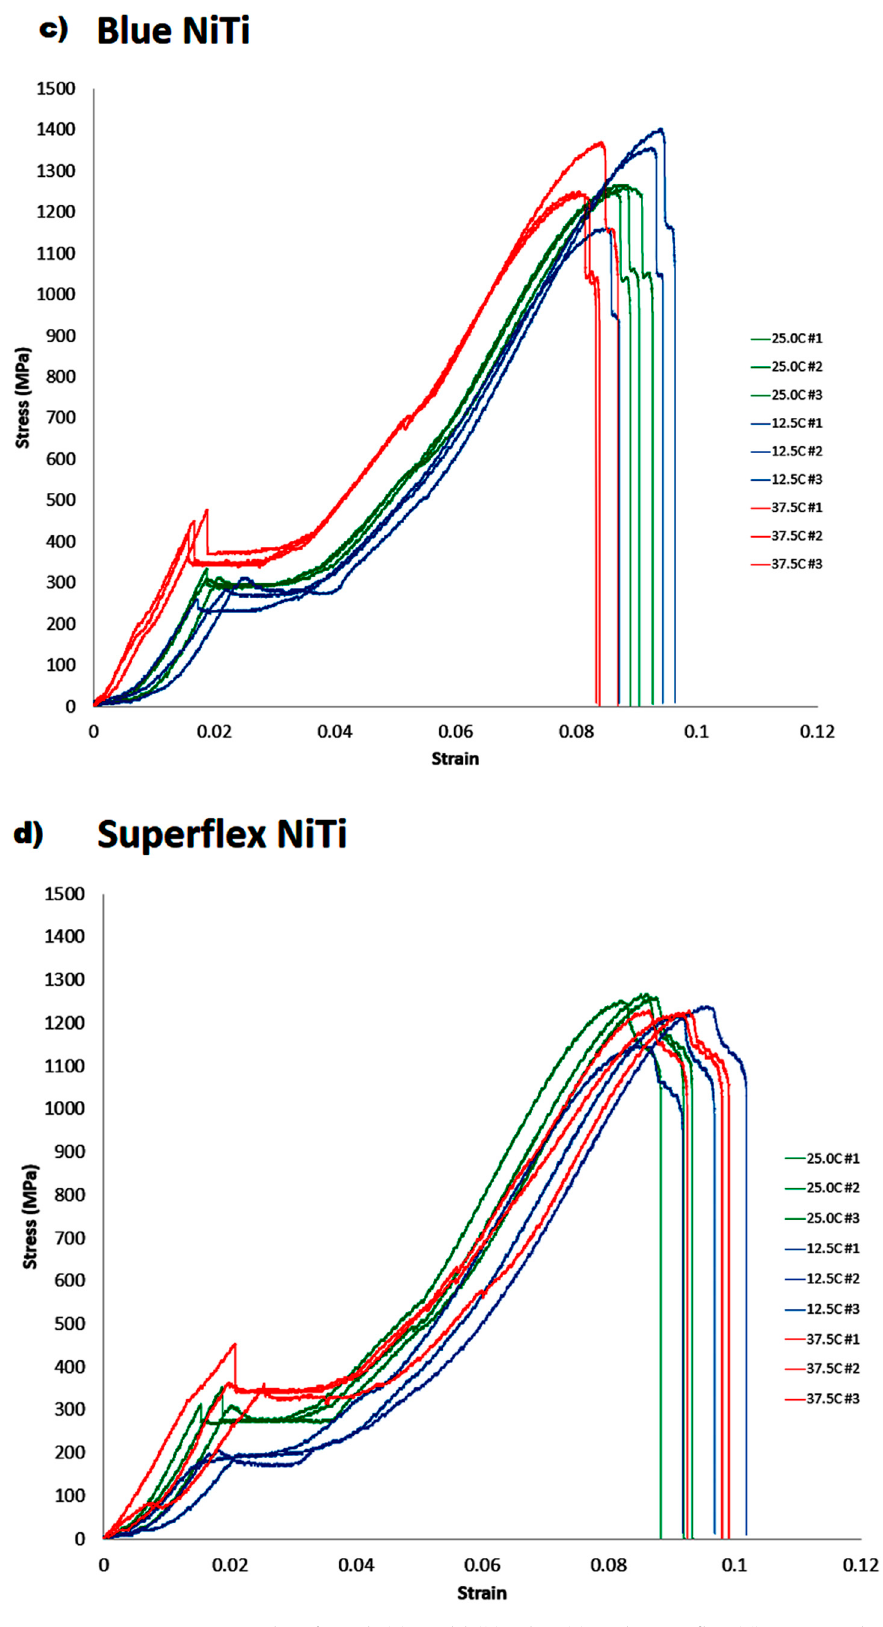
Figure 7. Stress–strain graphs of Stock ( a ), Gold ( b ), Blue ( c ) and Superflex ( d ) NiTi conducted across 12.5 °C, 25.0 °C, and 37.5 °C.